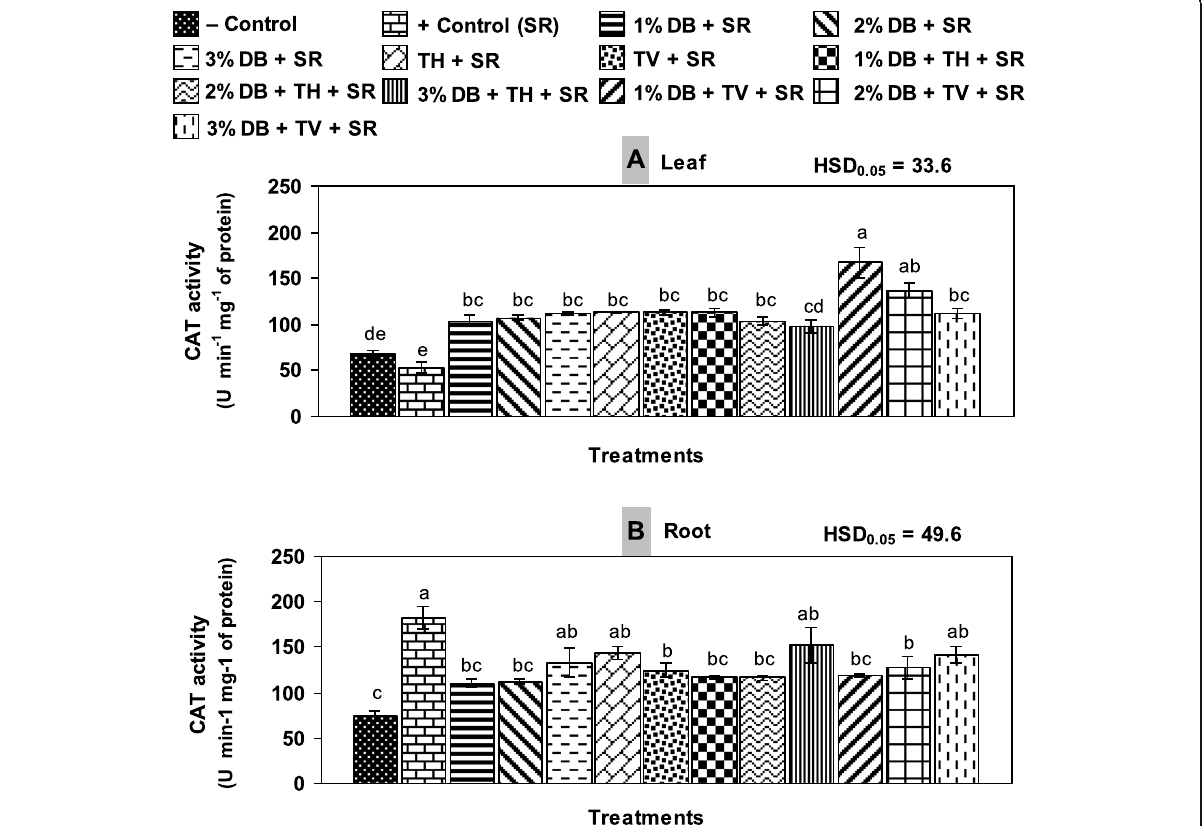
Fig. 4 Effect of Sclerotium rolfsii (SR), Trichoderma harzianum (TH), T. viride (TV), and dry biomass (DB) of Chenopodium album on leaf and root catalase activity (CAT) of chickpea var. Noor 2009. Vertical bars show standard errors of means of five replicates. Values with different letters at their top show significant difference ( p ≤ 0.05) as determined by Tukey ’ s HSD